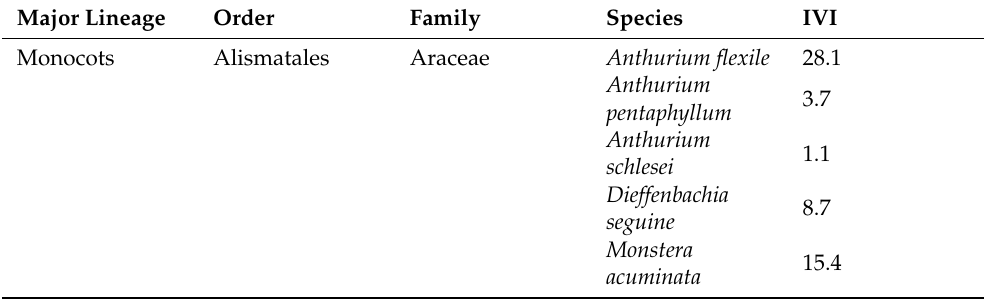
Table 1. Understory species encountered, and their corresponding Importance Value Index